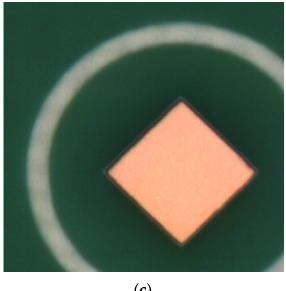
Figure 9. True negative PCB sections: ( a ) True negative PCB sample 1. ( b ) True negative PCB sample 2. ( c ) True negative PCB sample 3.